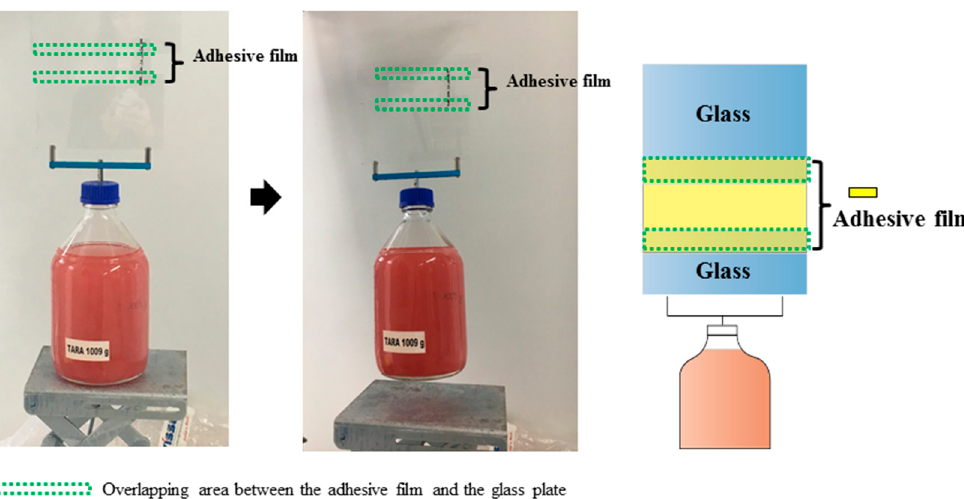
Figure 4. Demonstration of shear adhesion. Photograph showing a glass bottle (2000 ml, 1 kg) filled with 2 kg water mixed with red colorant (left); Illustration of the setup for the shear adhesion demonstration (right). The dry adhesive film was obtained at d = − 363 µm. The overlap length was 10 cm; the total contact area was 14 cm².